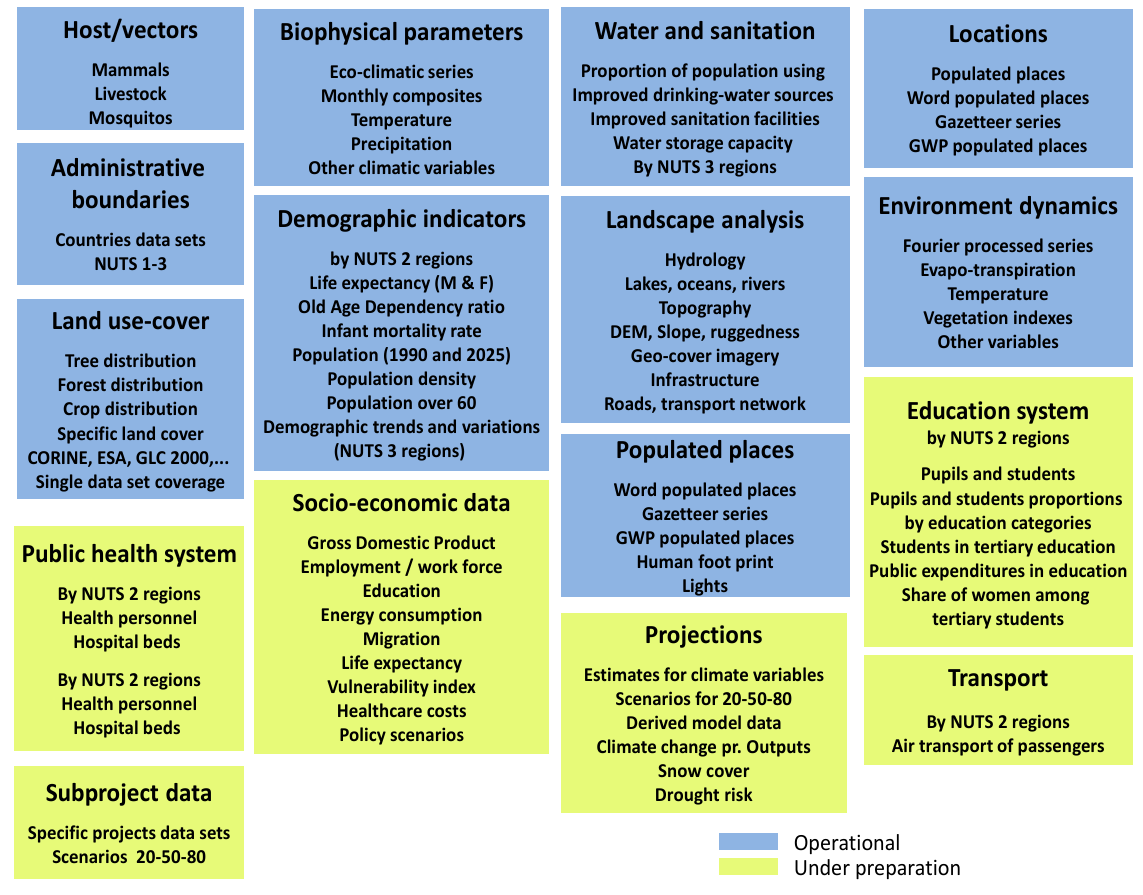
Figure 2. Datasets held in the E3